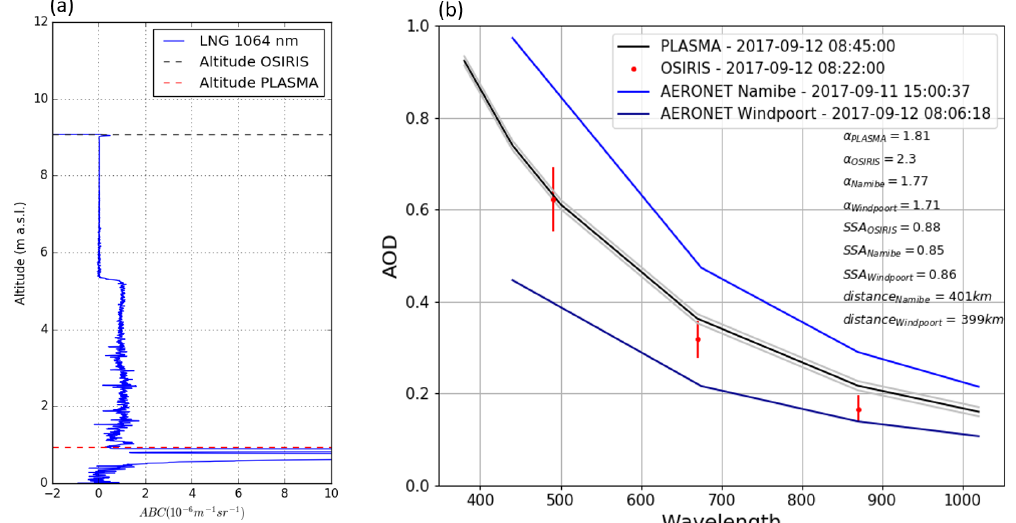
Figure 6. (a) Vertical profile of the aerosol backscatter coefficient (ABC) measured at 1064nm by the airborne lidar LNG before a loop descent performed on 12 September 2017. (b) Wavelength dependences of AOD measured at Namibe and Windpoort AERONET ground- based stations, compared to OSIRIS and PLASMA2 above-cloud AODs, estimated before and after the descent in the loop. Estimated error bars for AODs are also reported for OSIRIS (red bars) and PLASMA (grey